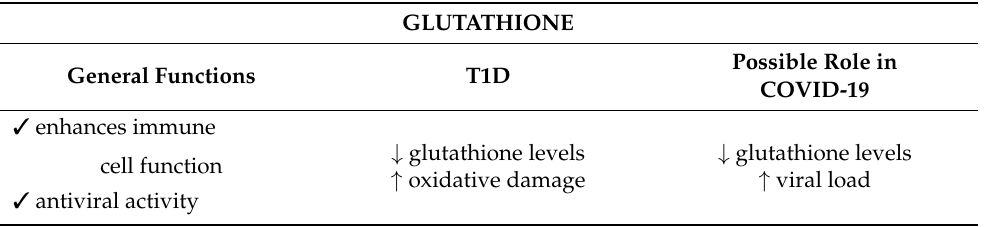
Table 4. Evidences related to glutathione’s role in T1D, and its possible association with